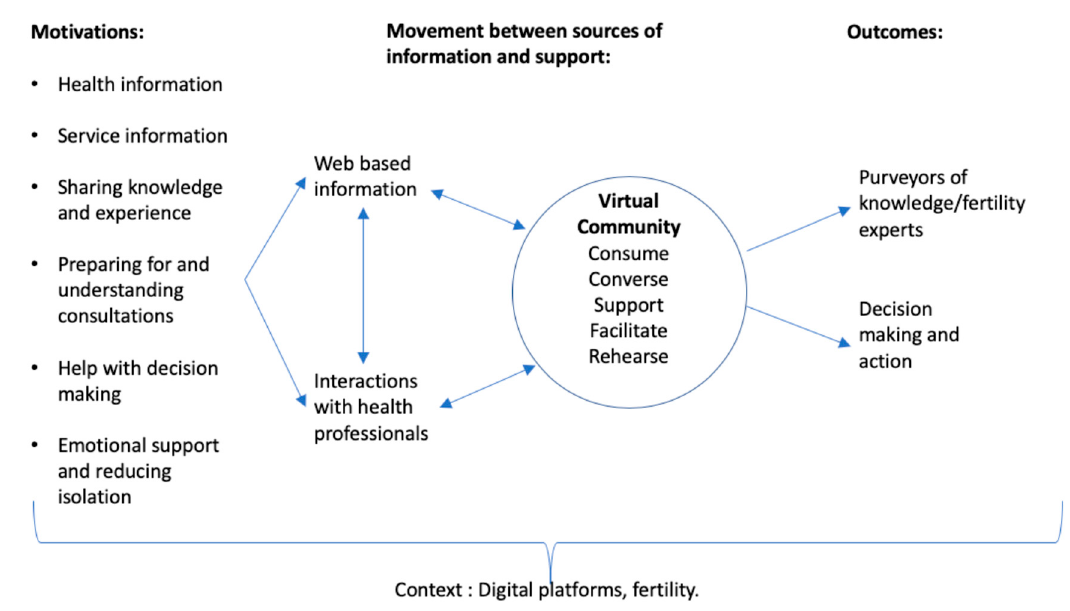
Figure 1. New conceptualization of eHealth Literacy in context of infertility.